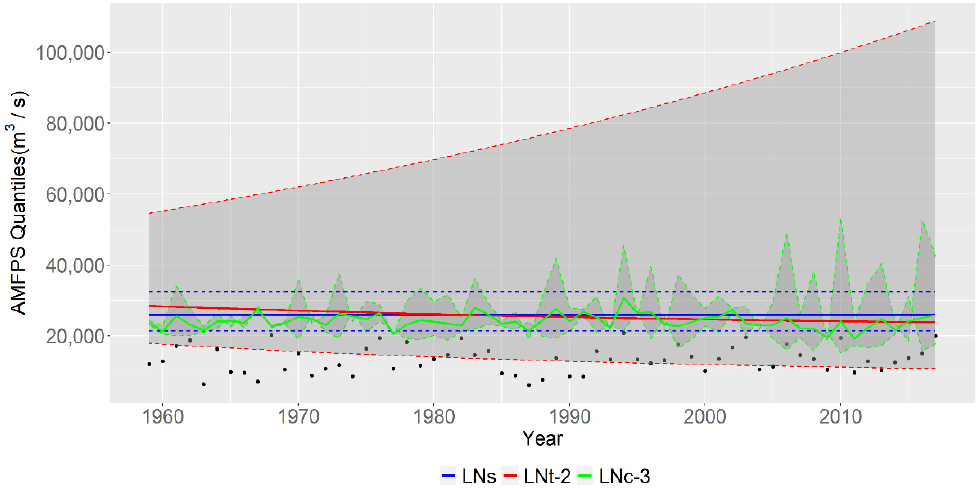
Figure 6. The 0.99 quantiles (solid lines) and uncertainty with 90% credibility intervals (areas inside the dashed line) of each model. Black dots are the observed AMFP in each year.